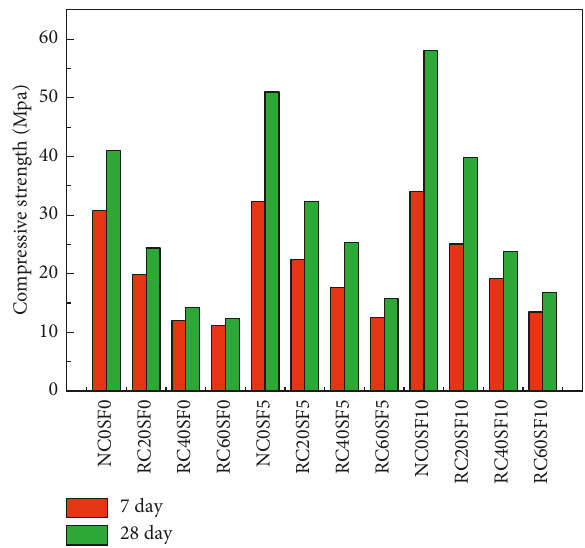
Figure 5: Compressive strength at days 7 and